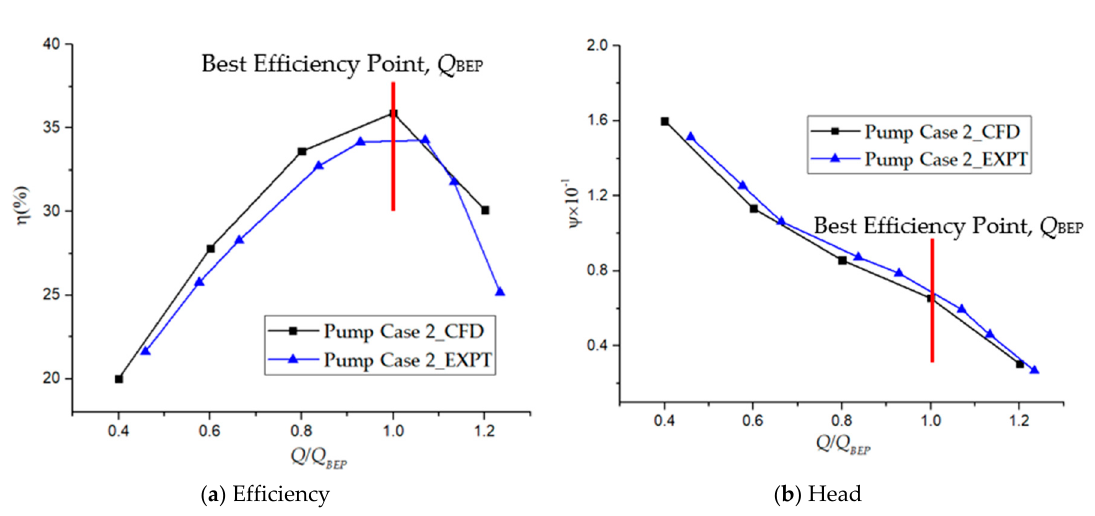
Figure 6. Performance curves comparison of the test pump.